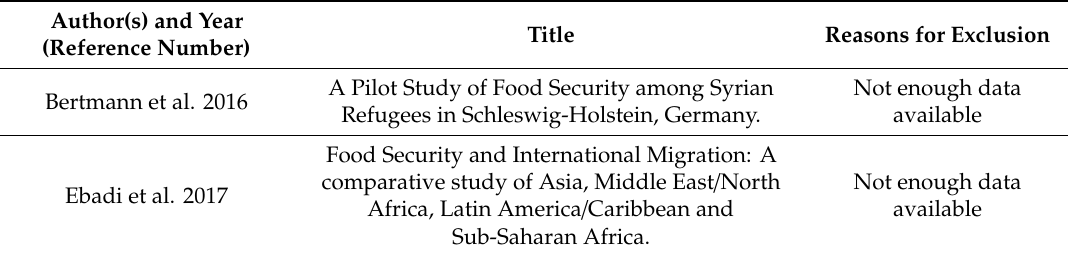
Table A3. Reasons for Excluded